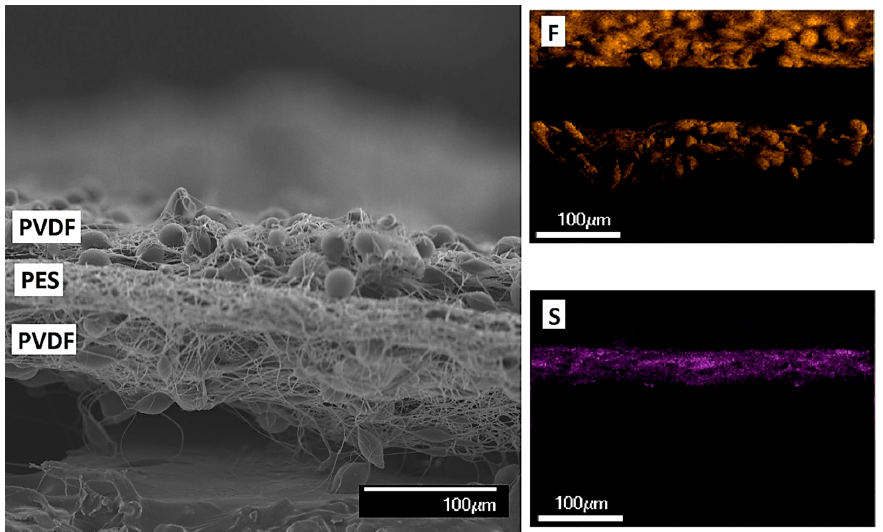
Figure 2. SEM image and energy-dispersive X-ray spectroscopy (EDS) mapping of the cross-section of the TL-115 membrane. Magnification ×230, the yellow color for the fluoride and the purple for the sulfur.